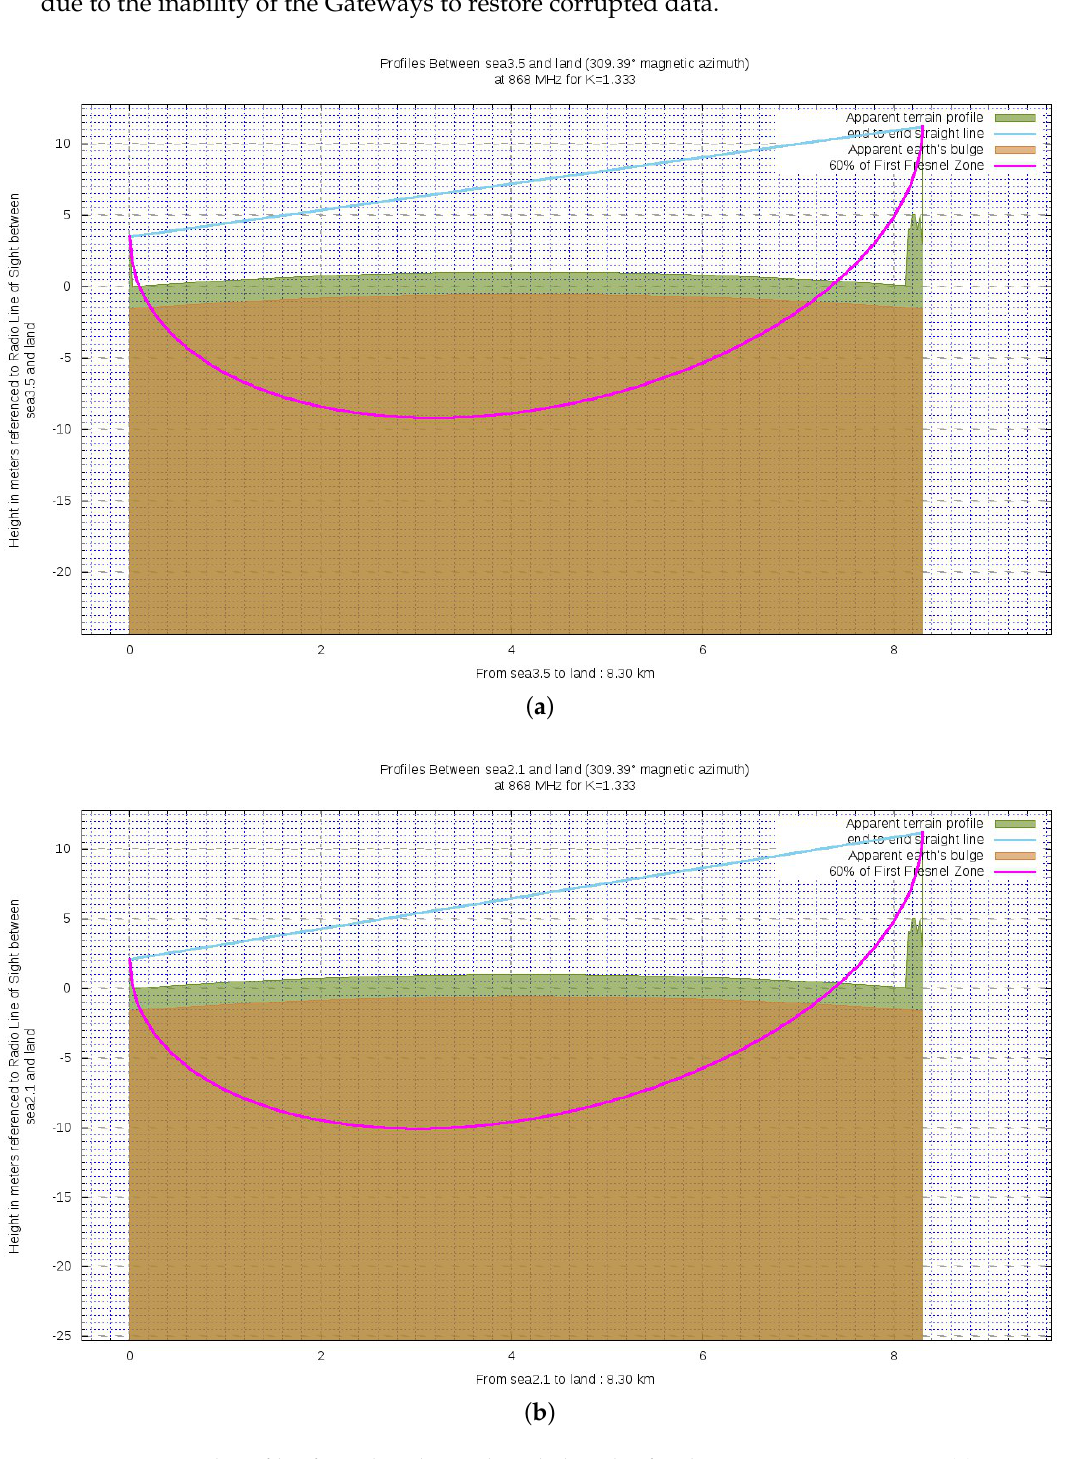
Figure 8. Ground profiles for either the exploited altitudes for the transmitting antenna: ( a ) 3.5 m; ( b ) 2.1